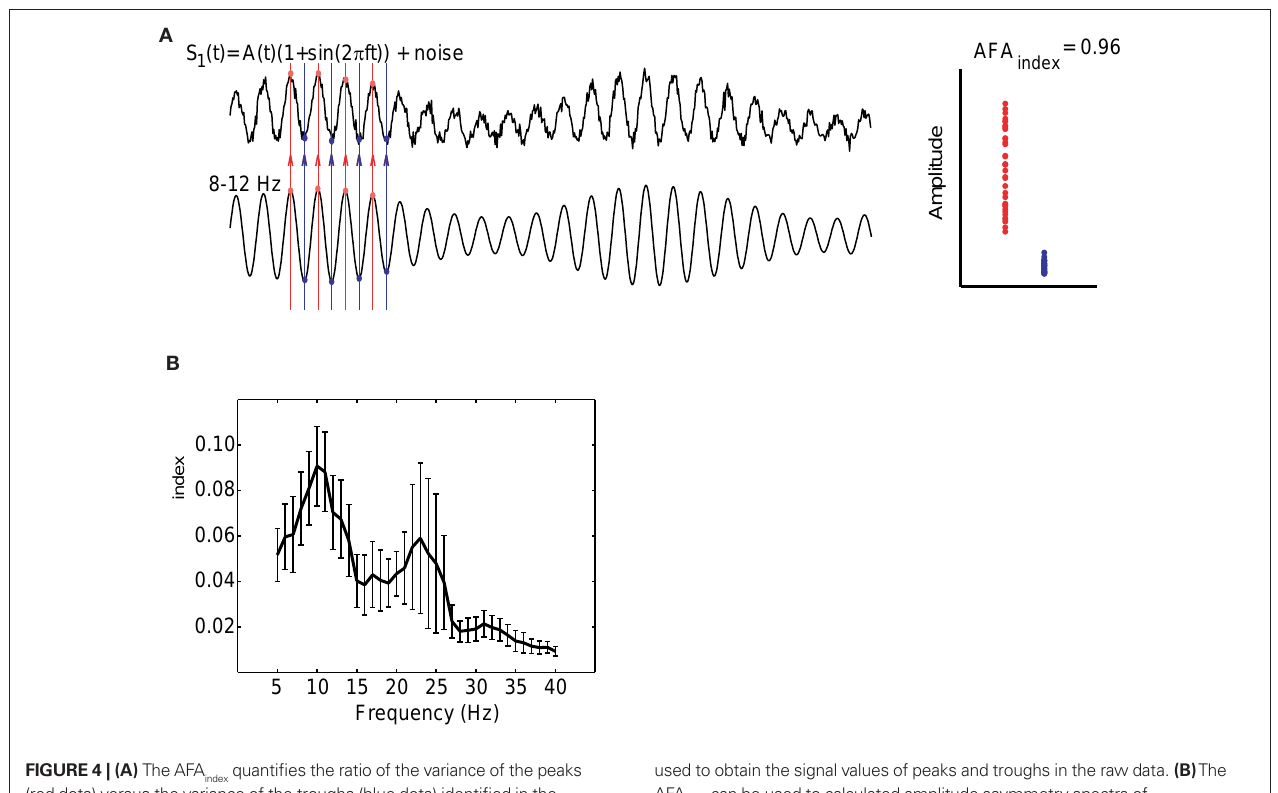
Figure 4 | (A) The AFA quantifies the ratio of the variance of the peaks index (red dots) versus the variance of the troughs (blue dots) identified in the ongoing oscillatory signal. The signal is first bandpass-filtered in the frequency band of interest. Next the time points for the peaks and troughs of the bandpassed data can be identified. These time points can then be